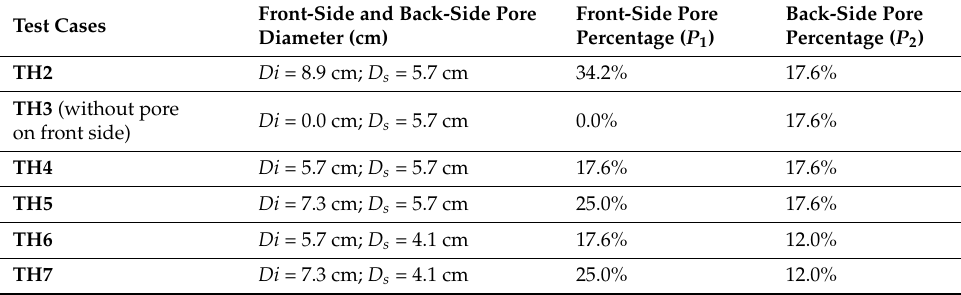
Table 4. Pore percentages in the experimental block surface in test cases.